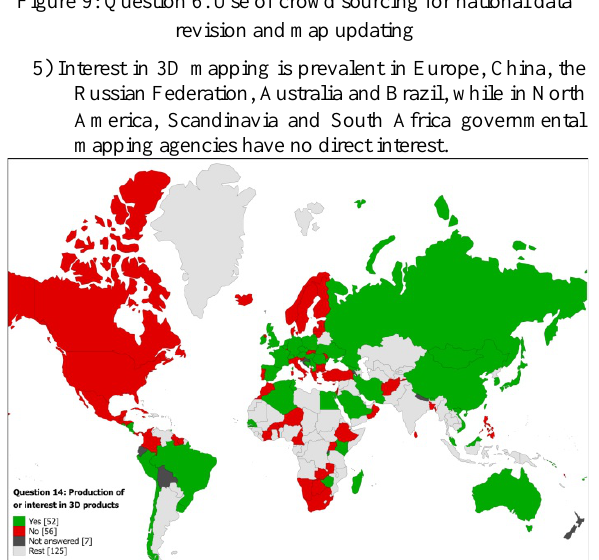
Figure 10: Question 14. Production or intention to produce 3D urban and rural landscape models and/or product